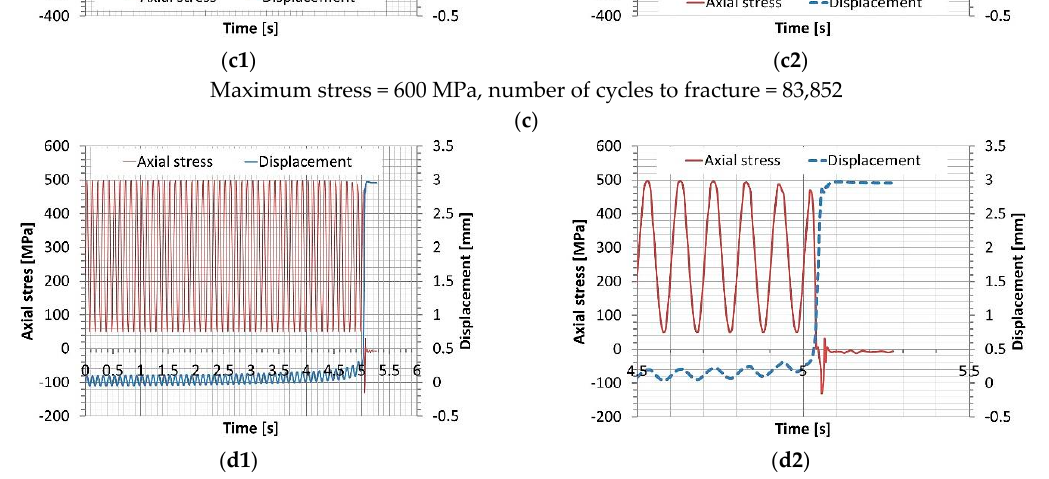
Figure 12. Variations of axial stress and displacement before fracture of the weld under the following values of maximum stress: ( a ) 950 MPa, ( b ) 800 MPa, ( c ) 600 MPa, ( d ) 500 MPa.